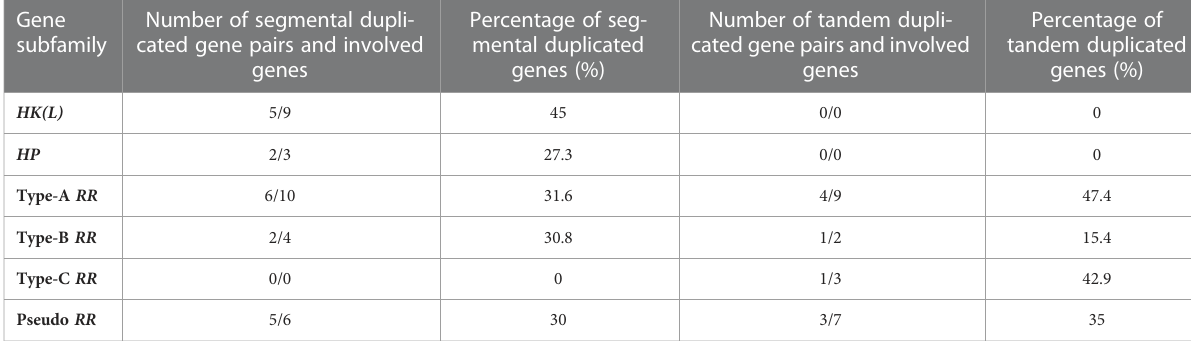
TABLE 2 Comparisons of segmental and tandem duplicated TCS genes in Ipomoea batatas